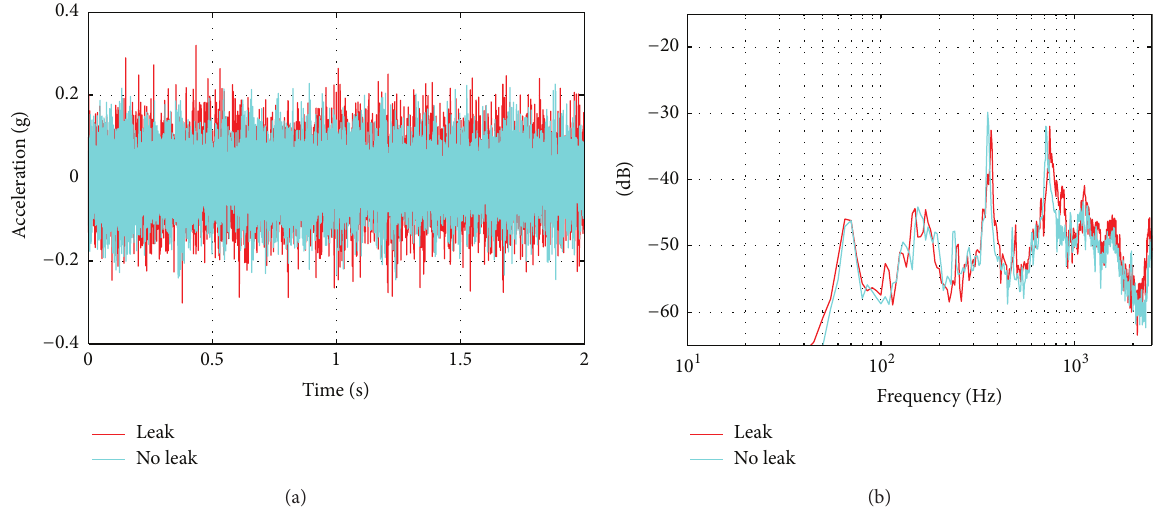
Figure 1: Preliminary vibration measurements with water consumption: (a) time domain, (b) frequency